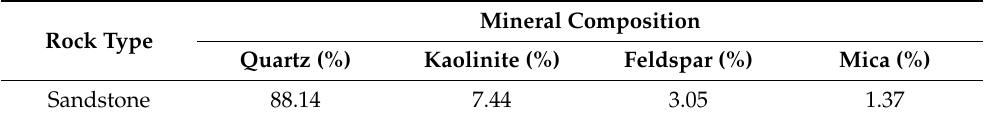
Figure 1. Location of the sampling site: ( a ) location of the Jiama open pit copper mine; ( b ) distribution map for frozen soil of China. Table 1. Mineral composition of sandstone